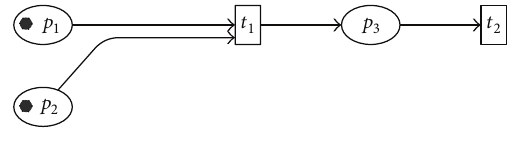
Figure 1: The net in initial state.